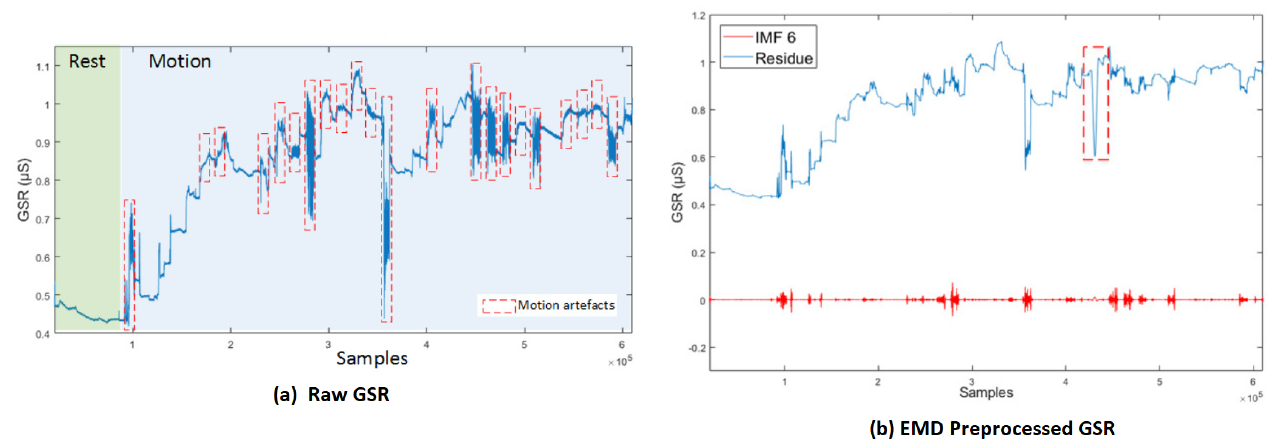
Figure 7. ( a ) Raw GSR: rest and motion phases. Signals corresponding to the movements involving the right hand are delimited by red lines. ( b ) GSR decomposition based on EMD, IMF6 and its respective residue